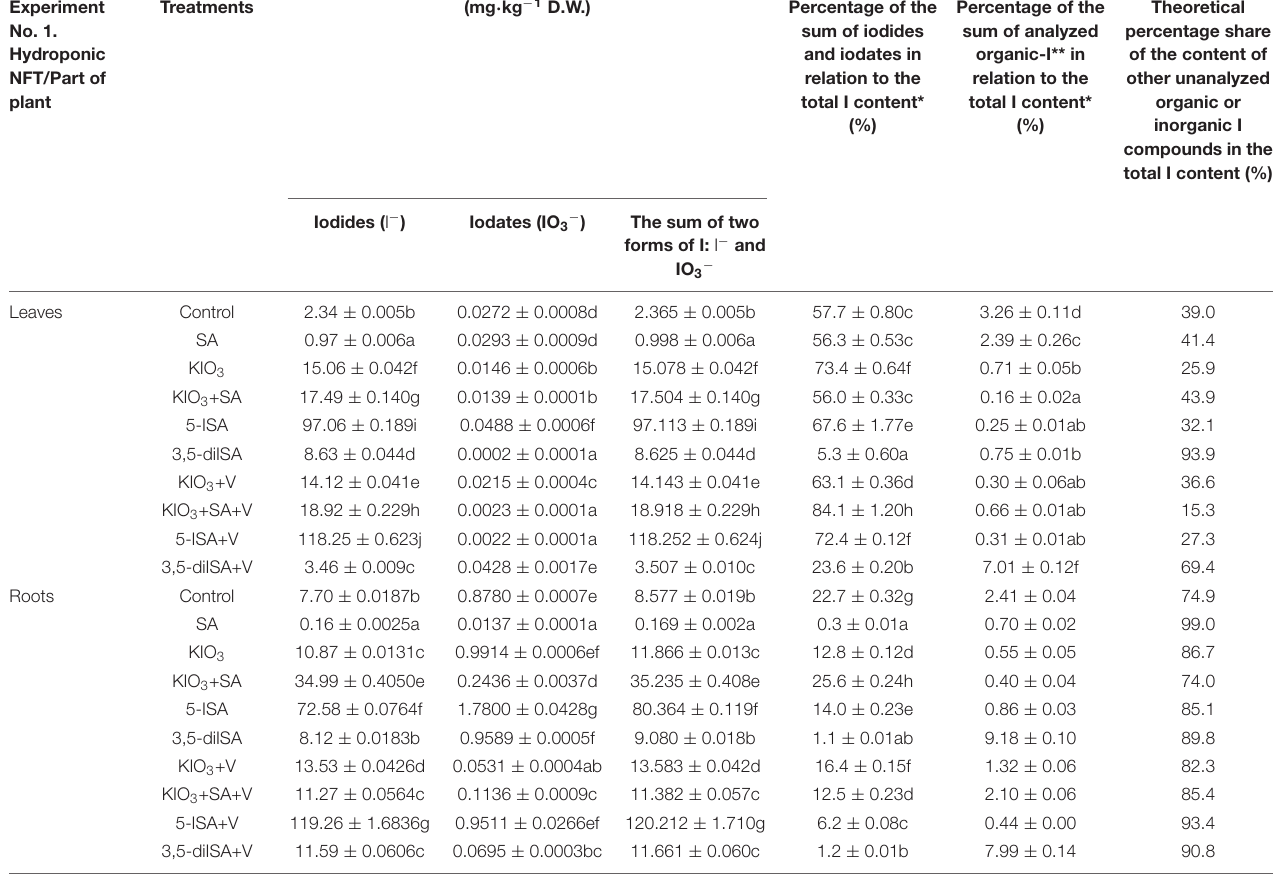
TABLE 5 | Concentrations of iodides (I − ) and iodates (IO 3 − ) in roots and leaves of lettuce in hydroponics NFT Experiment No. 1 (speciation of iodine analyzed HPLC-ICP-MS/MS) as well percentage of the iodides and iodates in relation to the total iodine. Experiment No.